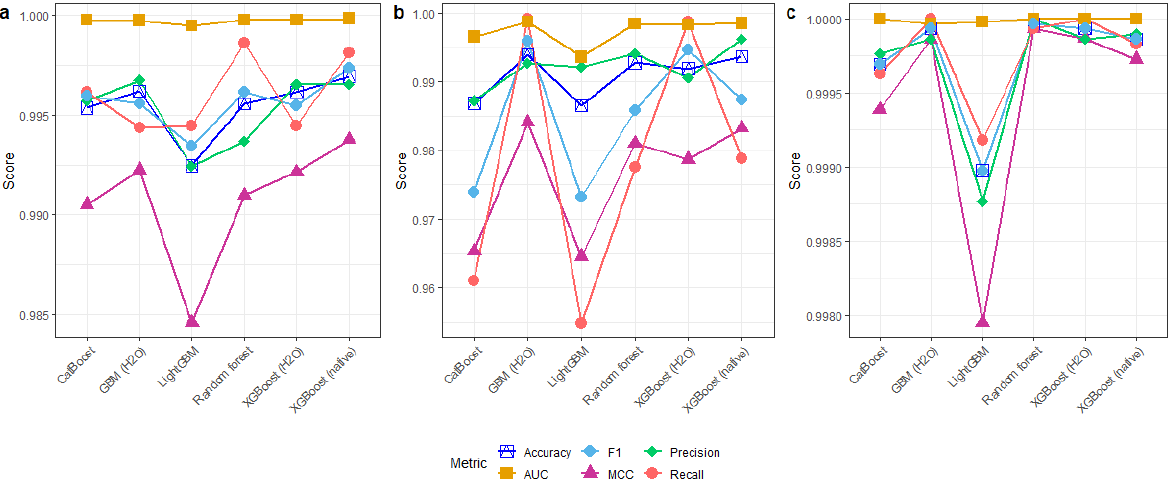
Figure 4. Performance comparison of various tree-based ensemble models on different datasets,